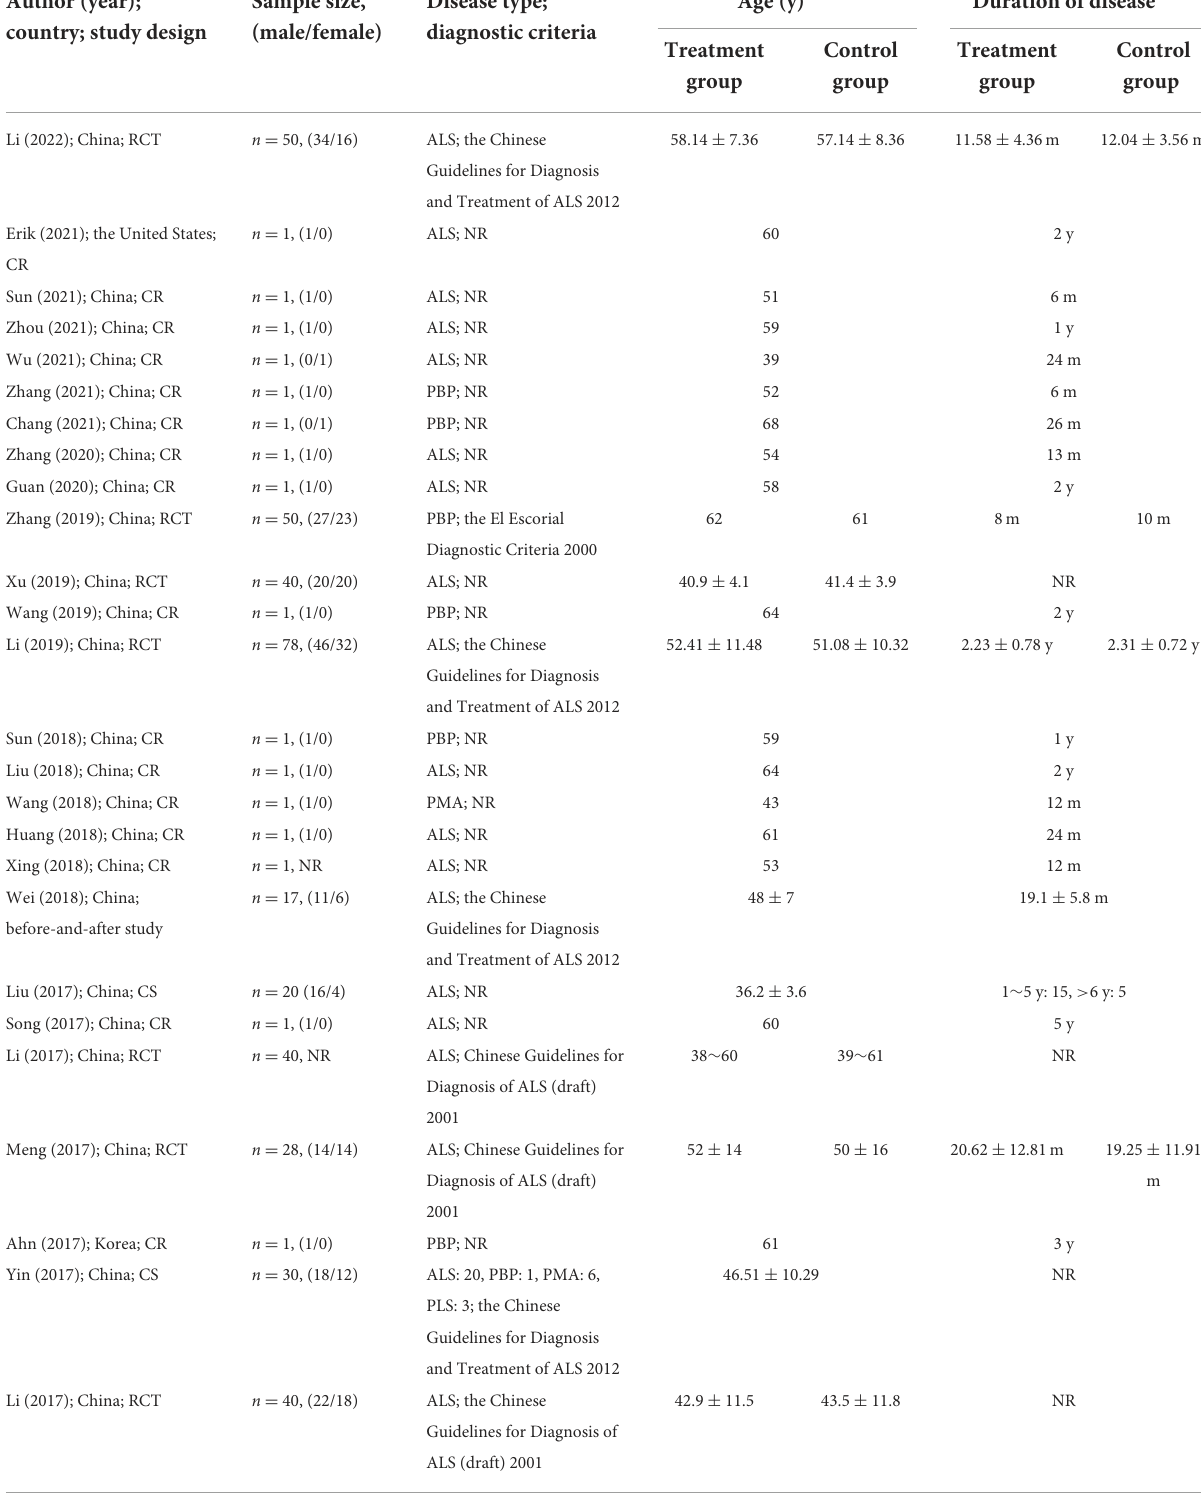
TABLE 2 Demographic and clinical characteristics of